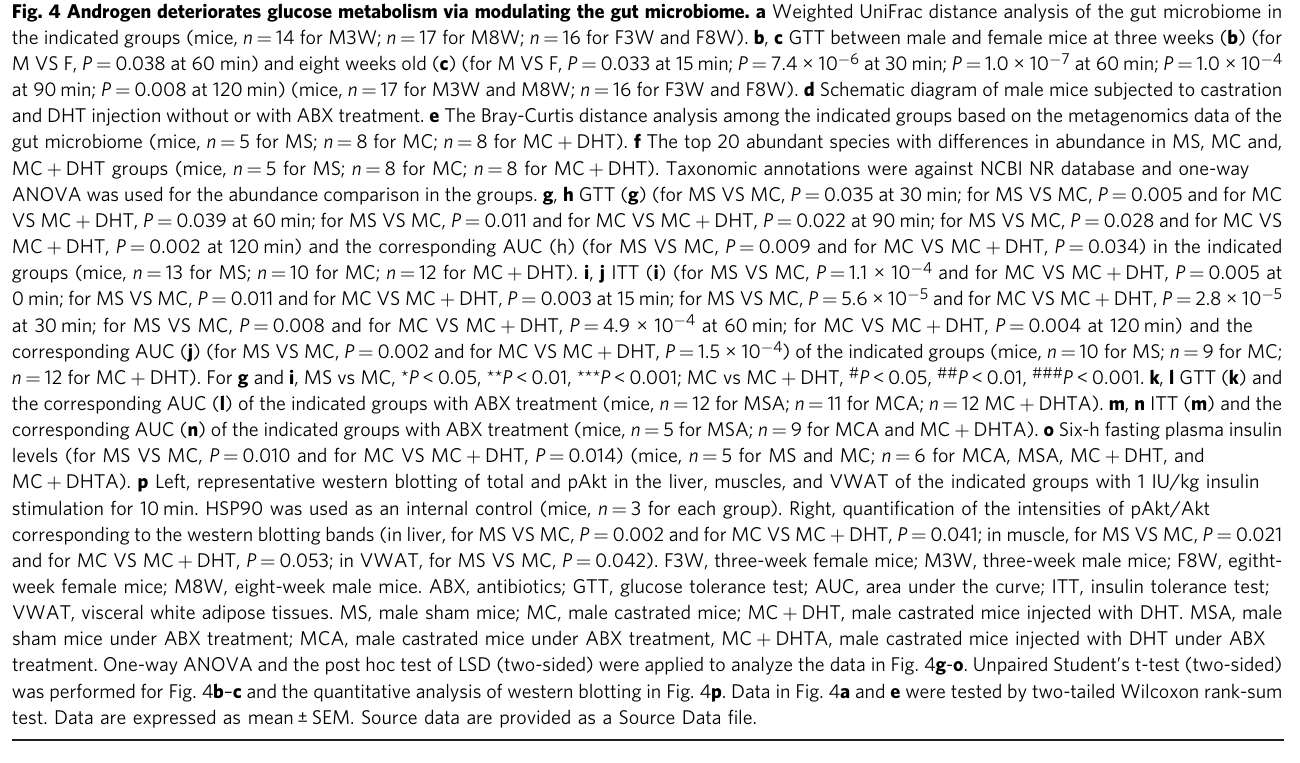
Fig. 4 Androgen deteriorates glucose metabolism via modulating the gut microbiome. a Weighted UniFrac distance analysis of the gut microbiome in the indicated groups (mice, n = 14 for M3W; n = 17 for M8W; n = 16 for F3W and F8W). b , c GTT between male and female mice at three weeks ( b ) (for M VS F, P = 0.038 at 60 min) and eight weeks old ( c ) (for M VS F, P = 0.033 at 15 min; P = 7.4 × 10 − 6 at 30 min; P = 1.0 × 10 − 7 at 60 min; P = 1.0 × 10 − 4 at 90 min; P = 0.008 at 120 min) (mice, n = 17 for M3W and M8W; n = 16 for F3W and F8W). d Schematic diagram of male mice subjected to castration and DHT injection without or with ABX treatment. e The Bray-Curtis distance analysis among the indicated groups based on the metagenomics data of the gut microbiome (mice, n = 5 for MS; n = 8 for MC; n = 8 for MC + DHT). f The top 20 abundant species with differences in abundance in MS, MC and, MC + DHT groups (mice, n = 5 for MS; n = 8 for MC; n = 8 for MC + DHT). Taxonomic annotations were against NCBI NR database and one-way ANOVA was used for the abundance comparison in the groups. g , h GTT ( g ) (for MS VS MC, P = 0.035 at 30 min; for MS VS MC, P = 0.005 and for MC VS MC + DHT, P = 0.039 at 60 min; for MS VS MC, P = 0.011 and for MC VS MC + DHT, P = 0.022 at 90 min; for MS VS MC, P = 0.028 and for MC VS MC + DHT, P = 0.002 at 120 min) and the corresponding AUC (h) (for MS VS MC, P = 0.009 and for MC VS MC + DHT, P = 0.034) in the indicated groups (mice, n = 13 for MS; n = 10 for MC; n = 12 for MC + DHT). i , j ITT ( i ) (for MS VS MC, P = 1.1 × 10 − 4 and for MC VS MC + DHT, P = 0.005 at 0 min; for MS VS MC, P = 0.011 and for MC VS MC + DHT, P = 0.003 at 15 min; for MS VS MC, P = 5.6 × 10 − 5 and for MC VS MC + DHT, P = 2.8 × 10 − 5 at 30 min; for MS VS MC, P = 0.008 and for MC VS MC + DHT, P = 4.9 × 10 − 4 at 60 min; for MC VS MC + DHT, P = 0.004 at 120 min) and